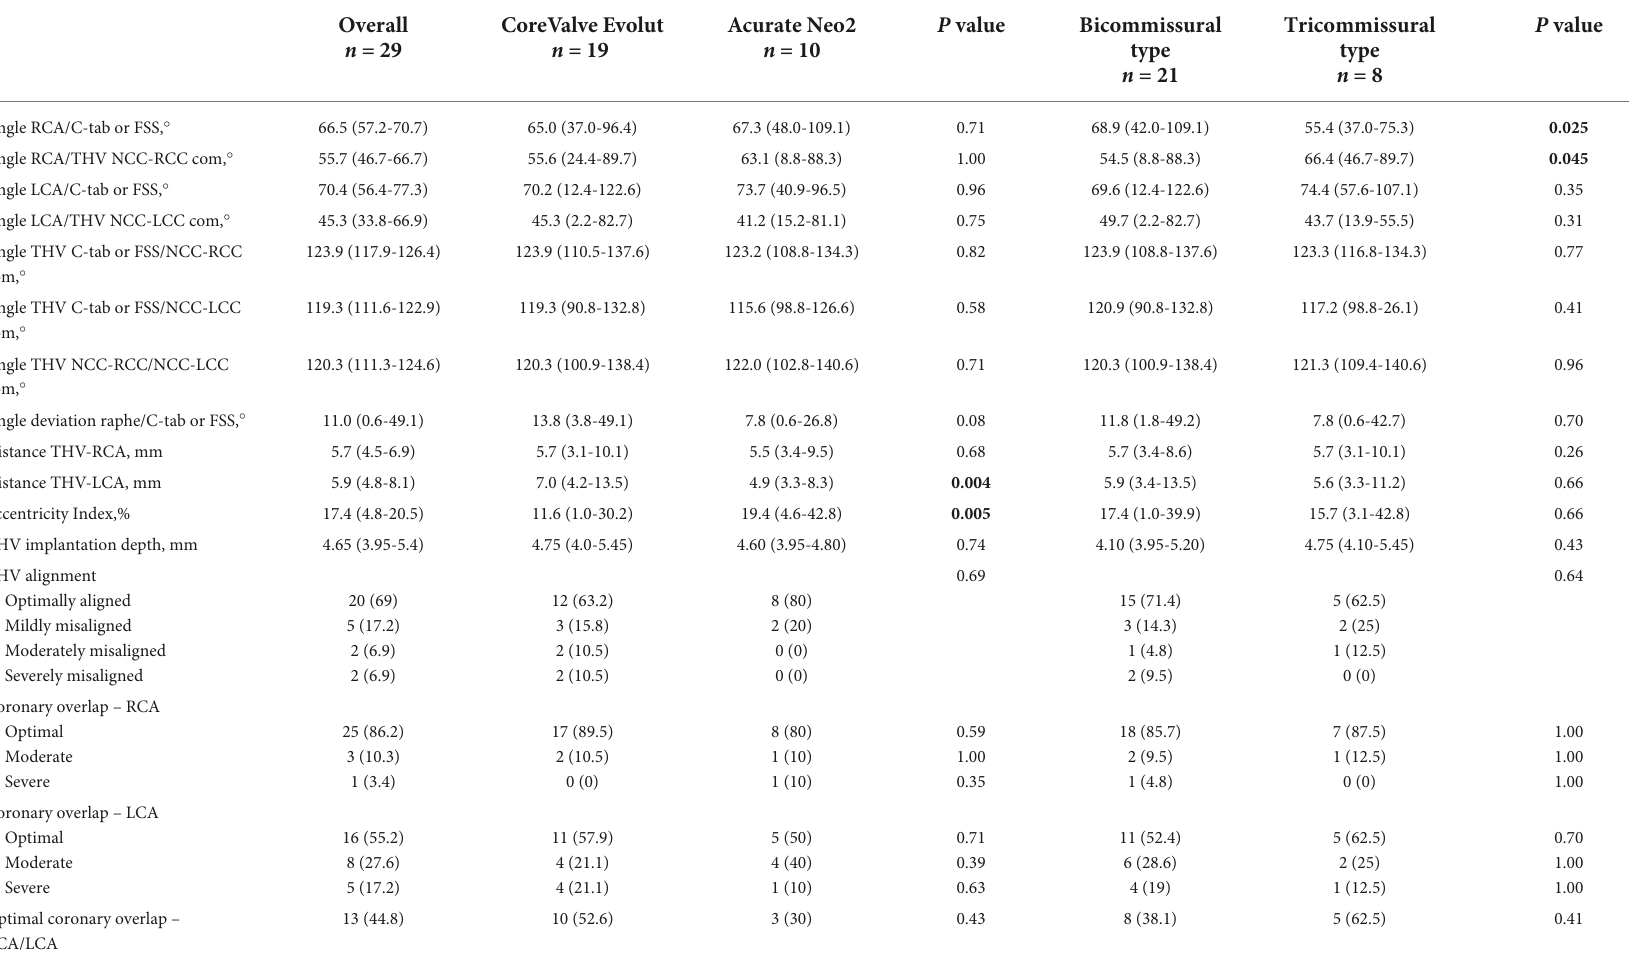
TABLE 4 Post-procedural CT analysis –Oriented